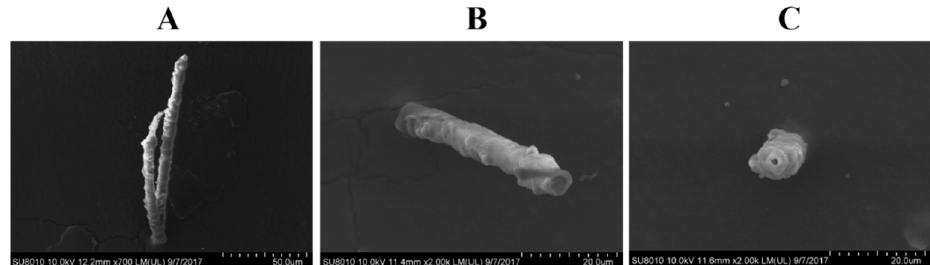
Figure 6. Effects of SFMLP knockdown on the morphology of the salivary sheath of WBPH ( A ) and ( B ) WBPH injected with dsGFP ; ( C ) WBPH injected with dsSFMLP .